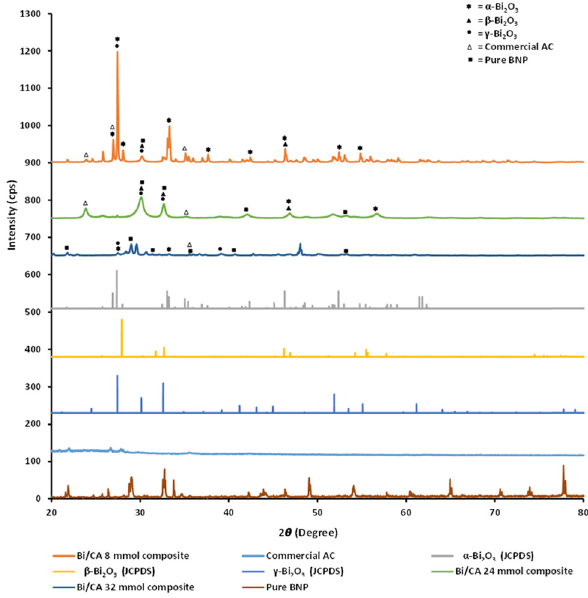
Figure 3: Di ff ractograms of 8, 24, and 32mmol Bi/AC composites along with Bi 2 O 3 ( JCPDS database under the numbers 41 - 1449 for α - Bi 2 O 3 , 27 - 0050 for β - Bi 2 O 3 , and45 - 1344 for γ - Bi 2 O 3 ) , commercial AC,and pure BNP.